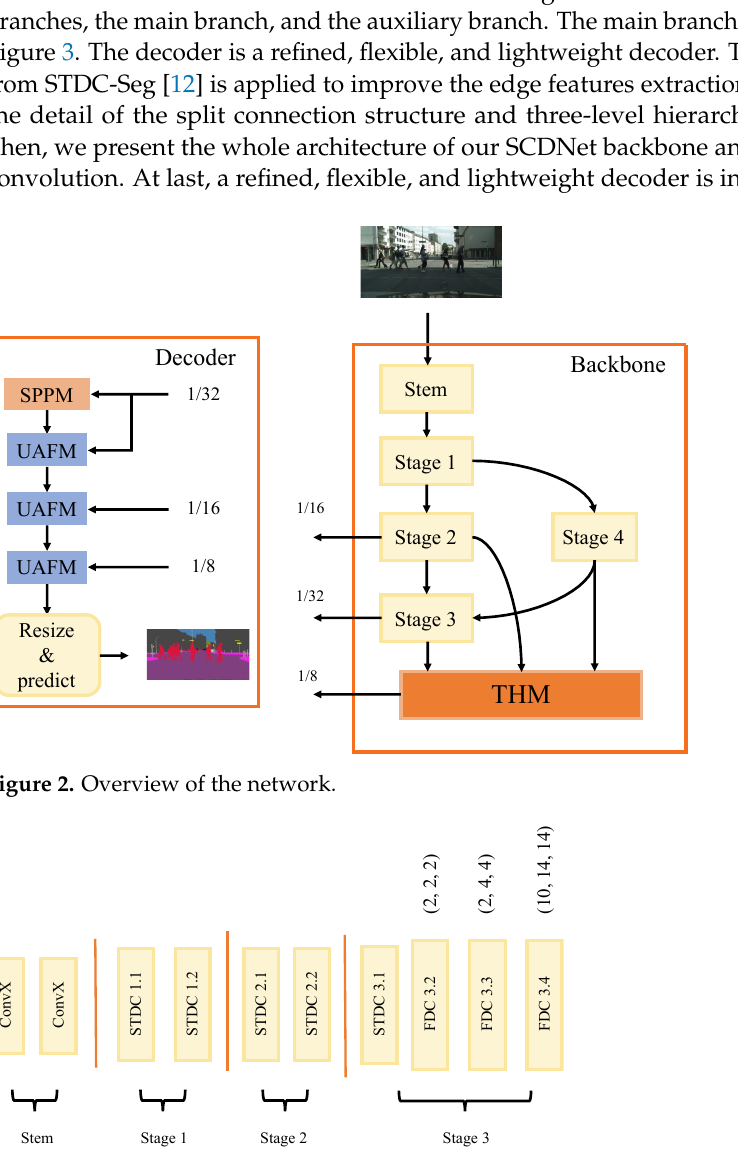
Figure 3. Main branch of backbone. It demonstrates the cascaded STDC blocks and FDC blocks. The three digits besides the FDC indicate the dilation rates of three ConvXD. The detailed information of FDC is shown in Figure